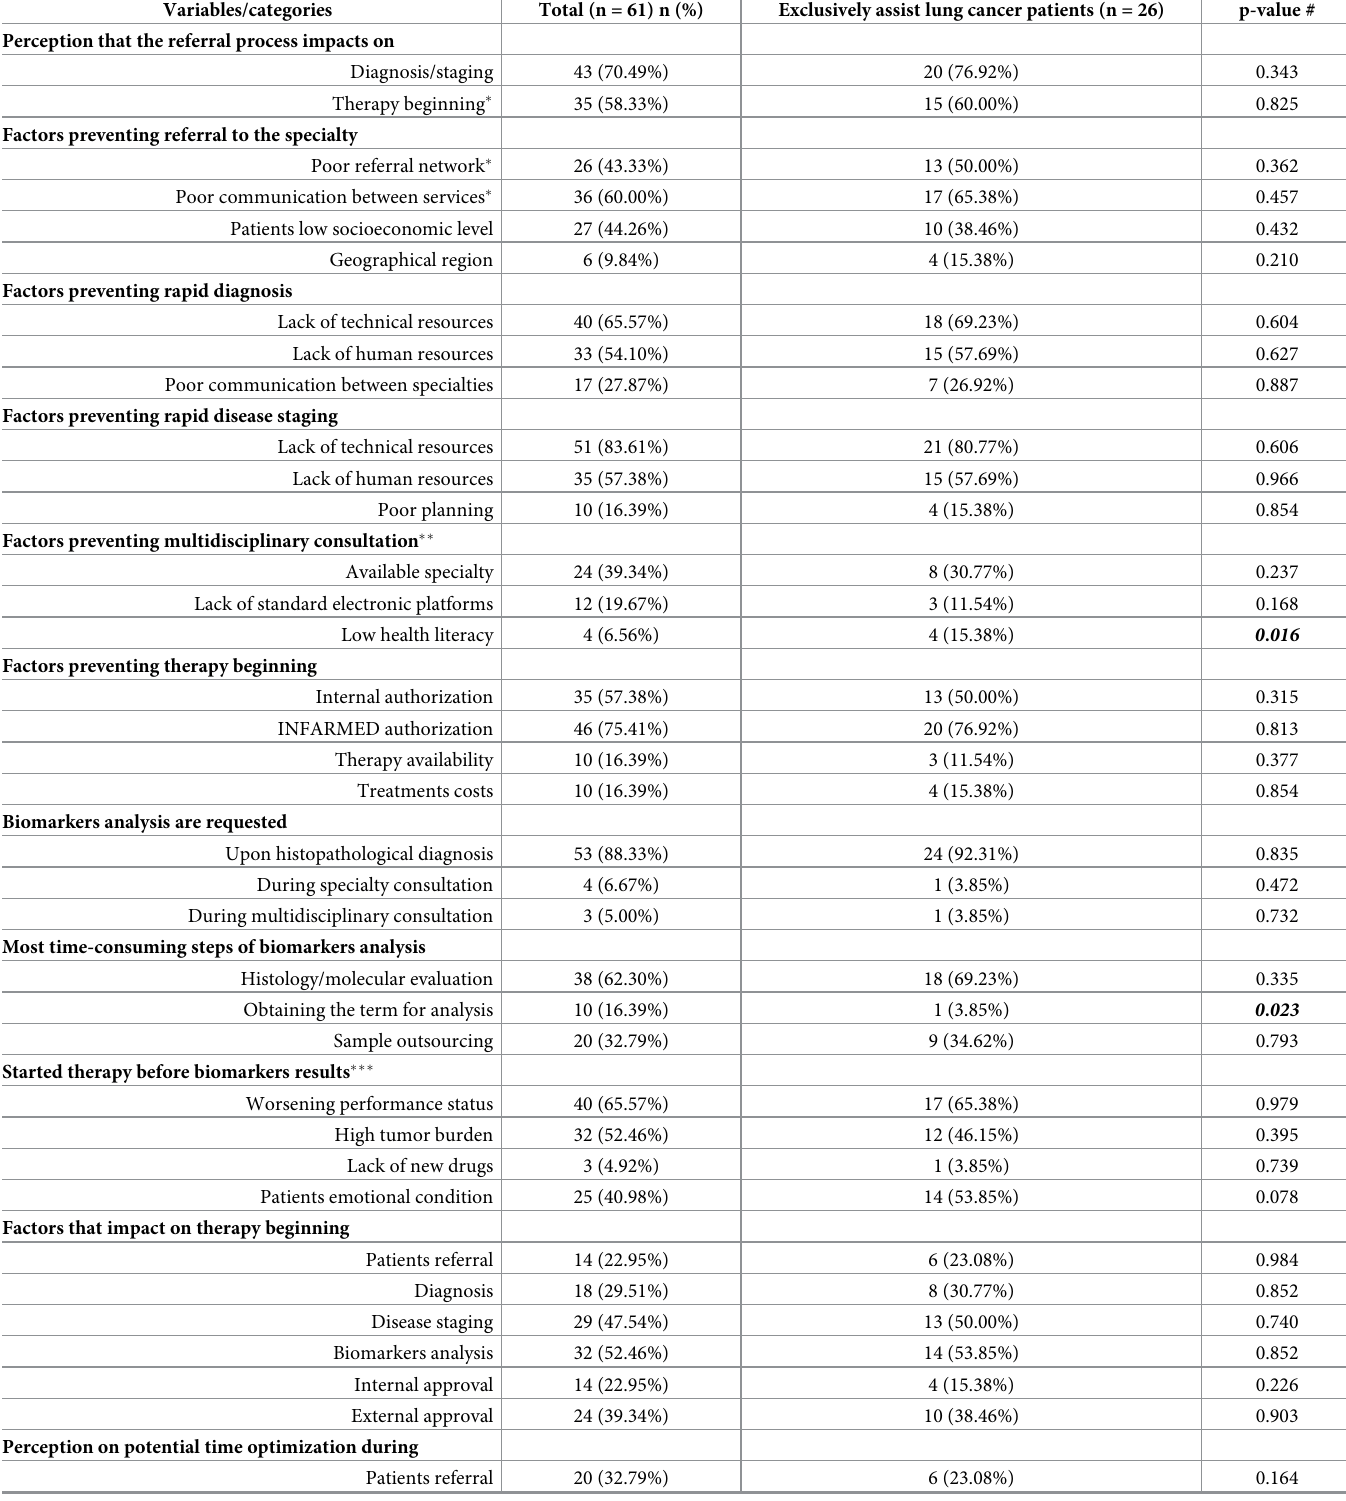
Table 2. Perceived barriers to diagnosis of lung cancer in